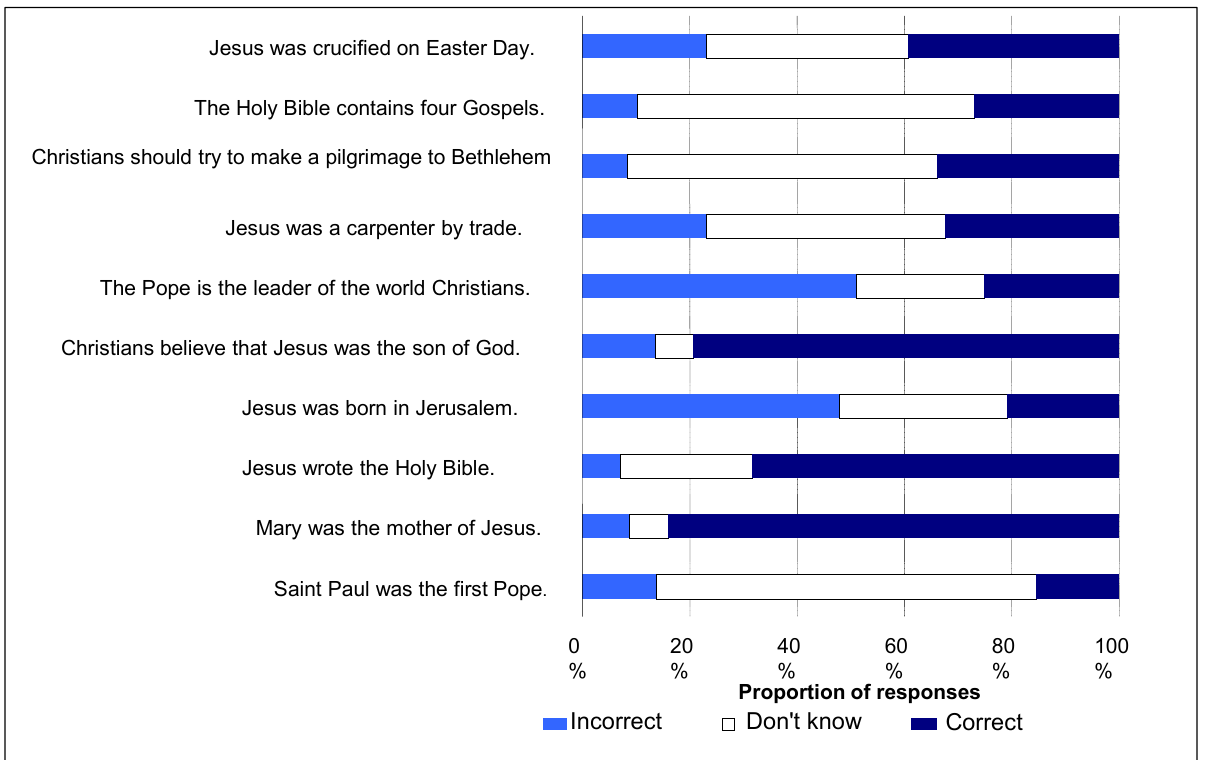
Figure 1 . Proportion of correct and incorrect